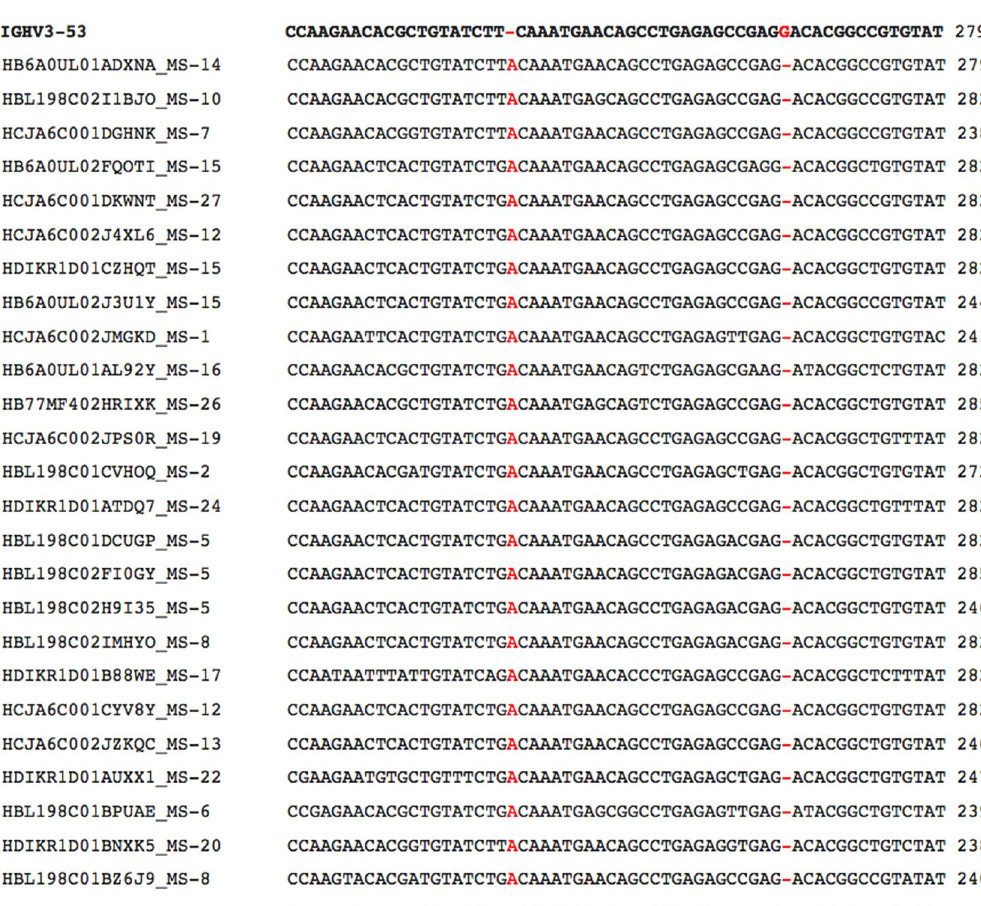
Additionally, the Heuristic did not encounter any motifs that matched to zero MS patients. Instead, a total of 19,104 motifs matched to a single MS patient. Each of these single-MS motifs matched between 15 and 20 Healthy Controls. All match counts for the single-MS motifs fell below the DOM-determining threshold of 60%.